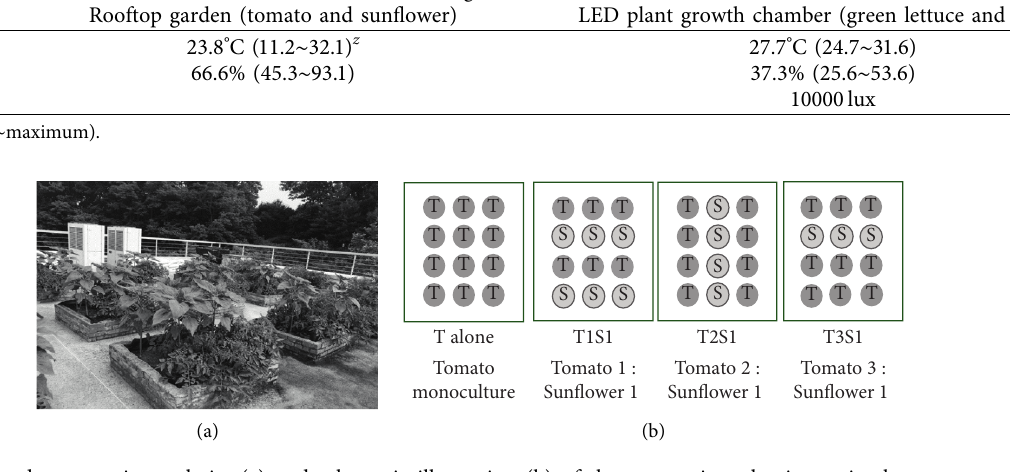
Figure 2: The outdoor experimental site (a) and schematic illustration (b) of the companion planting ratios between tomatoes and sunflowers in the plots on the rooftop